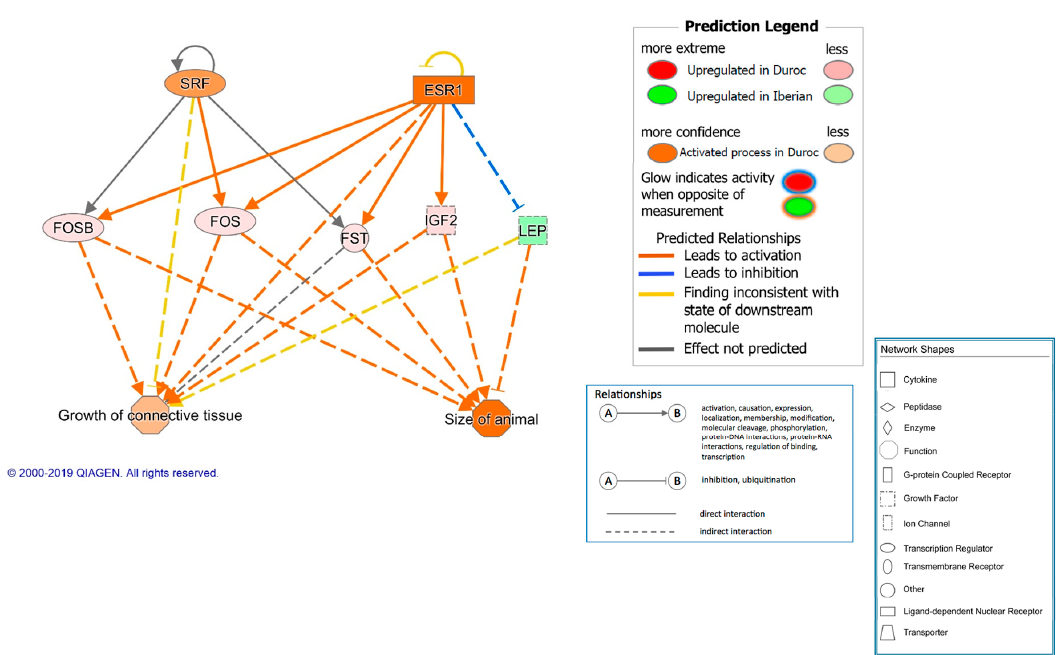
Figure 2. Regulator effects network predicted as activated in Duroc pigs.